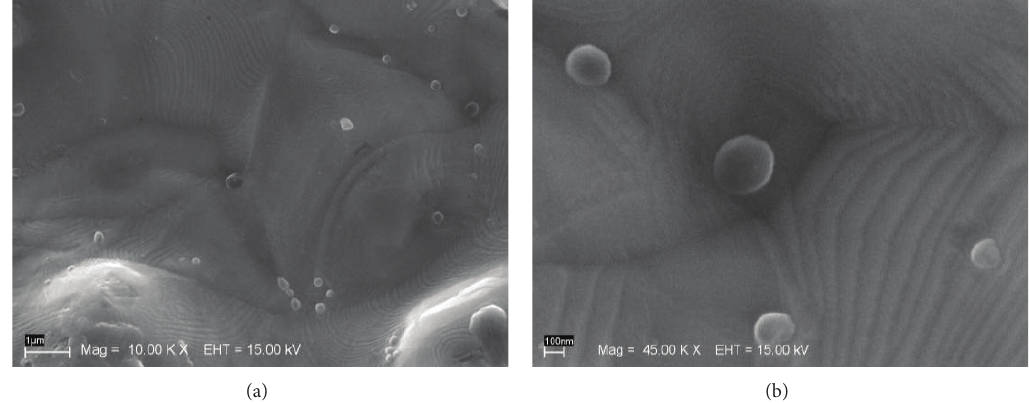
Figure 4: (a) Typical surface of the AstCrM particle and (b) spherical particulate features on powder particle surface.